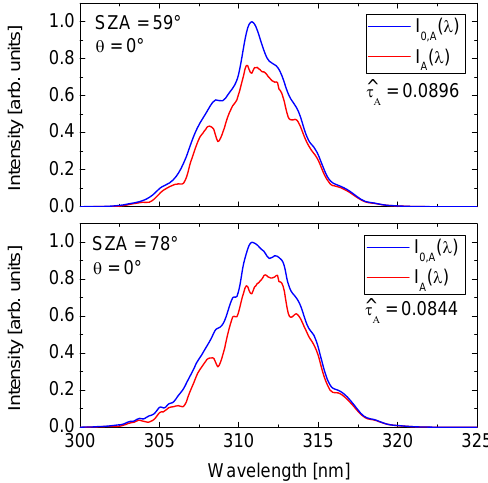
Fig. 4. Modeled light intensity I A passing filter A of the UV-camera as a function of wavelength λ for two different solar zenith angles (SZA). The blue curve ( I 0,A ) assumes no SO 2 in the optical path (background spectrum), while the red curve ( I A ) represents an SO 2 column density S of 400 ppmm. In both cases, light passes the filter in a perpendicular direction ( θ = 0). The ratio of integrated intensity under the background spectrum and under the measurement spectrum yields the indicated integrated optical density τ ˆ A according to Equation (7). The two weighted average optical densities τ ˆ A differ by 6%, even though the assumed SO 2 column density S was the same in both cases. 78 ◦ . The four curves calculated in this manner are shown in Fig. 4. The presence of Fraunhofer absorption lines and,